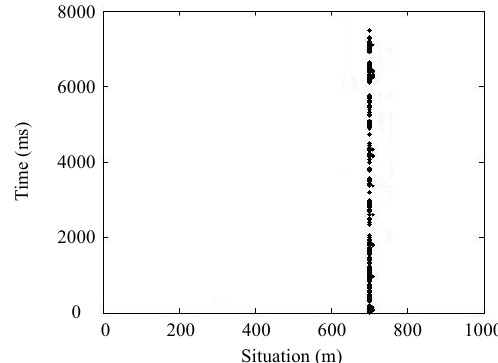
Fig. 12 Detection result of proposed method.